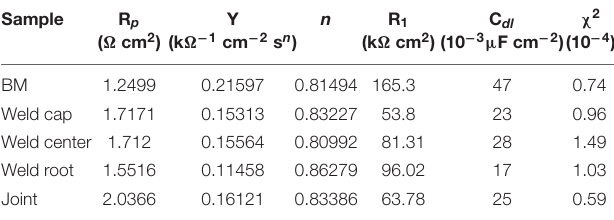
TABLE 4 | The fitted electrochemical parameters for EIS of different regions.